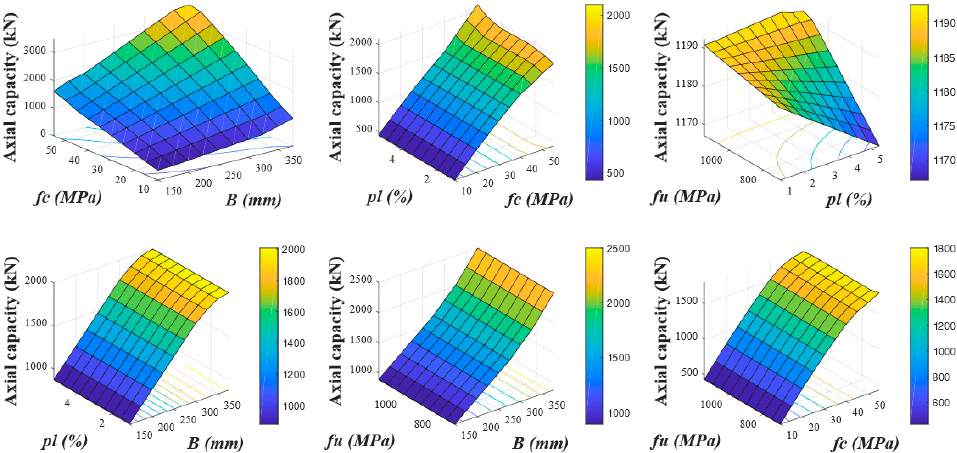
Figure 14. Parametric investigation using an empirical model.